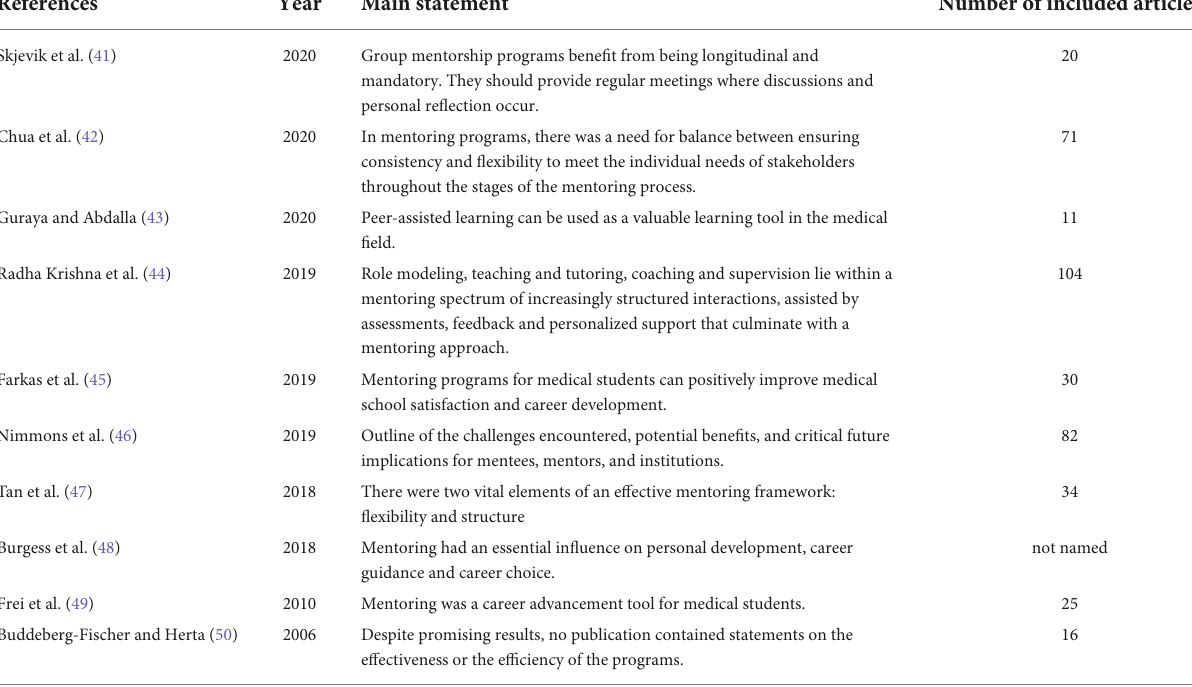
TABLE 1 Review articles searched by “mentoring” and “medical students” in PubMed on